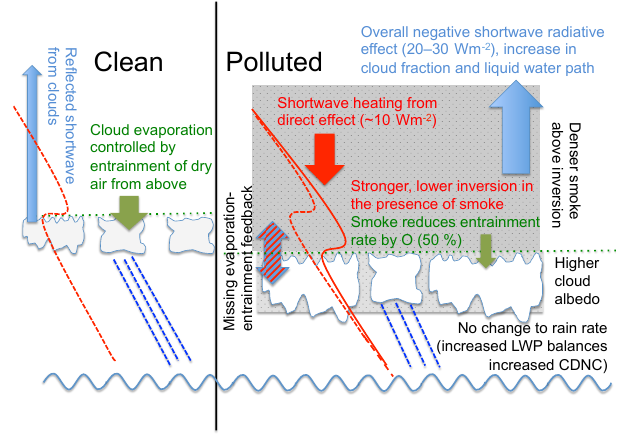
Figure 17. Diagram illustrating the different radiative effects of the smoke in our